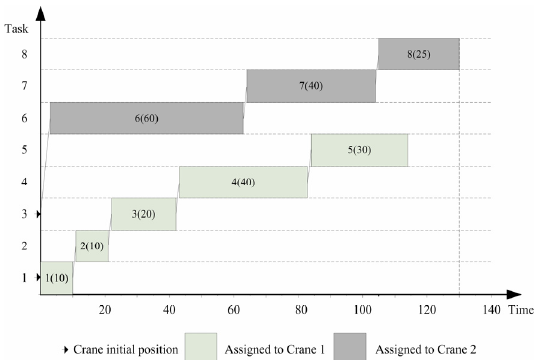
Fig. 5. The feasible schedule based on the proposed decoding